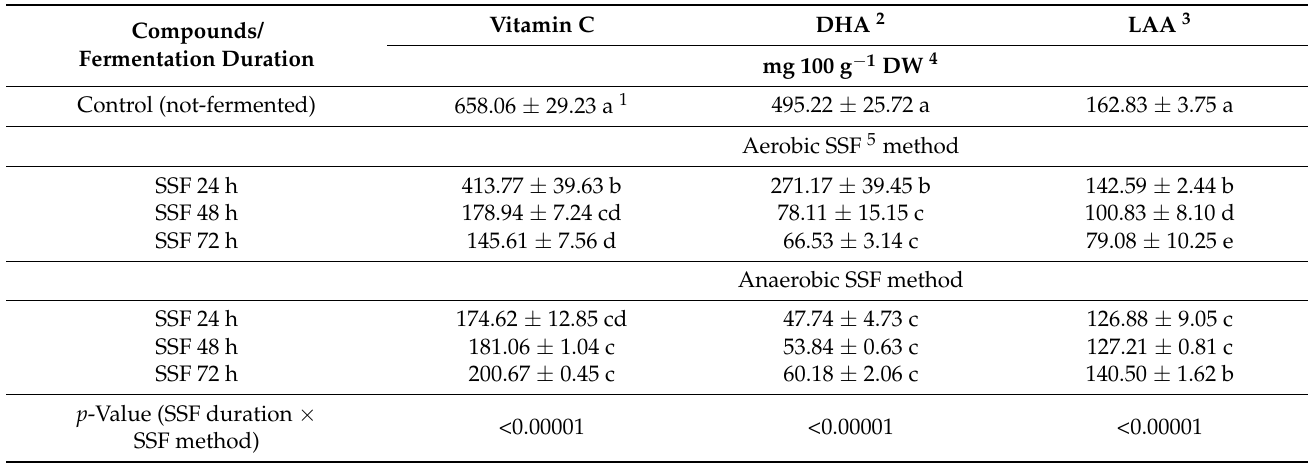
Table 1. The contents of vitamin C, DHA and LAA in willow herb leaves fermented under the different fermentation methods and duration.